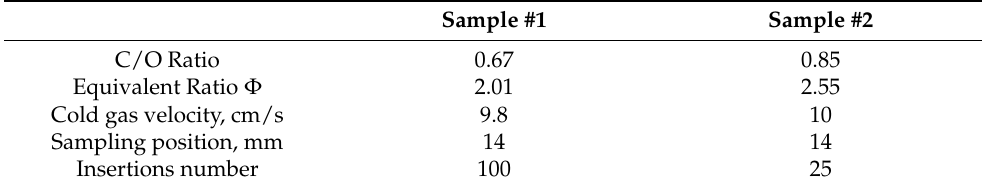
Table 1. Investigated flame reactor